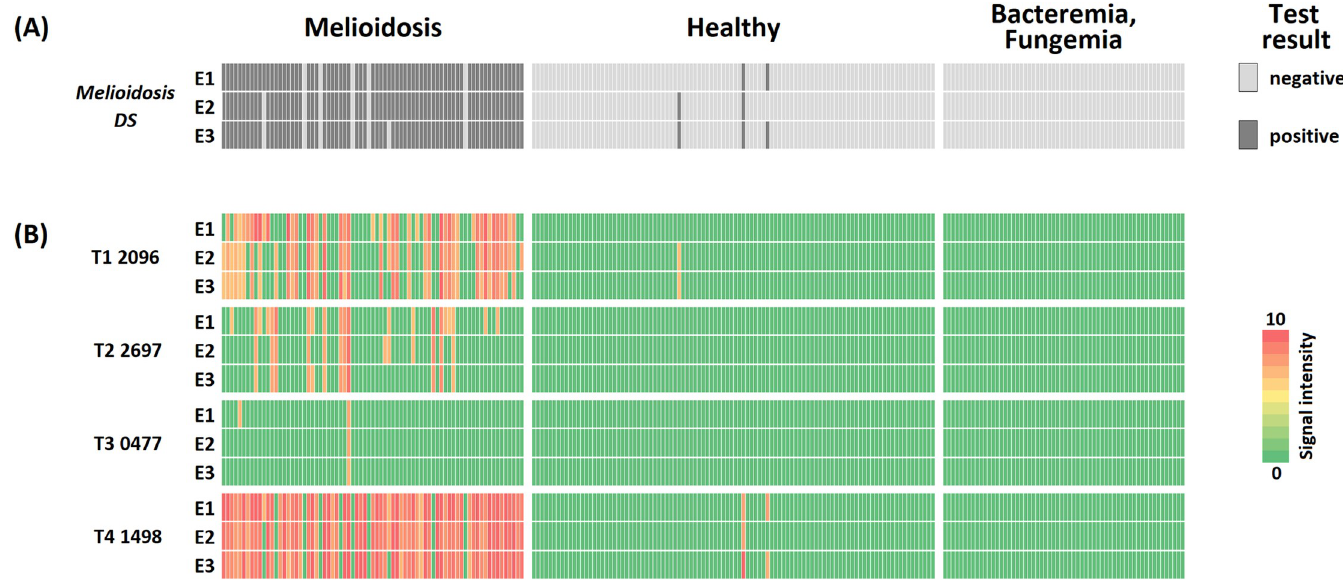
Fig 3. Heat map of melioidosis patient and control Melioidosis DS results shown for (A) the overall assay (positive if at least one test band shows a signal) and (B) all four protein antigens separately for three evaluators (E1, E2, E3). The semi-quantitative results for the single antigens were obtained by comparing the dipstick band intensities to the gold reference card. The melioidosis positive sera from were drawn upon admission to the hospital in Thailand (n = 75). The controls consist of healthy individuals from Thailand (n = 100) and German patients suffering from other infections (n = 60). Sera were diluted 1:100 for the Melioidosis DS rapid test.